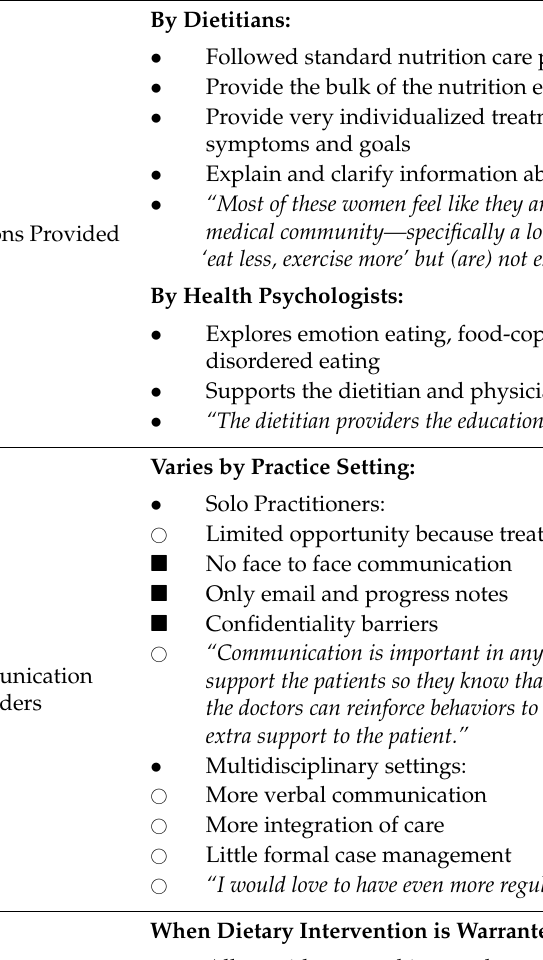
Emerging Theme with Supporting Excepts and